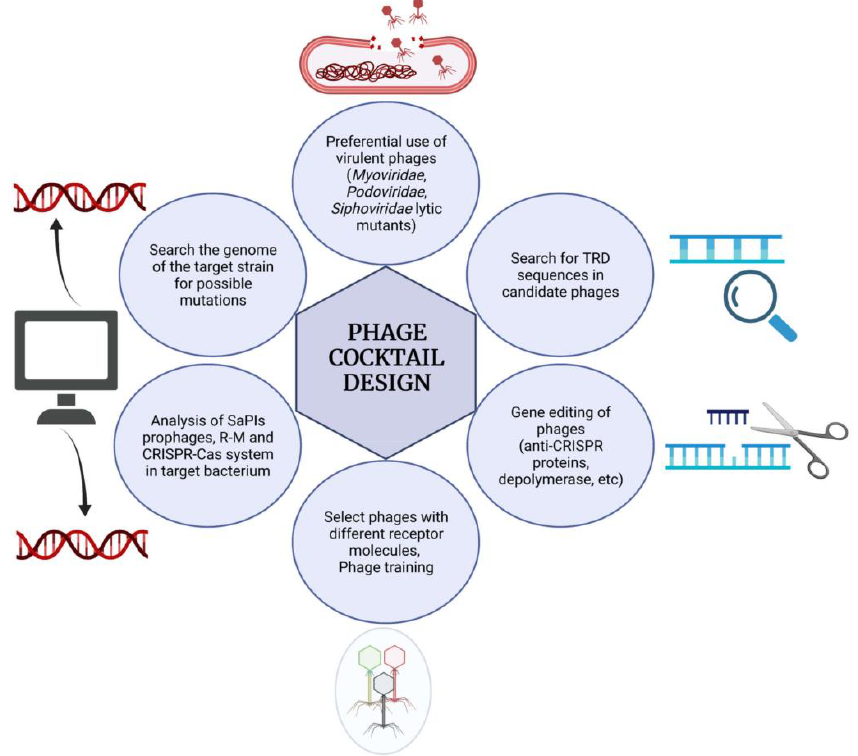
Figure 3. Schematic representation of different aspects that must be considered for rational phage cocktail design.